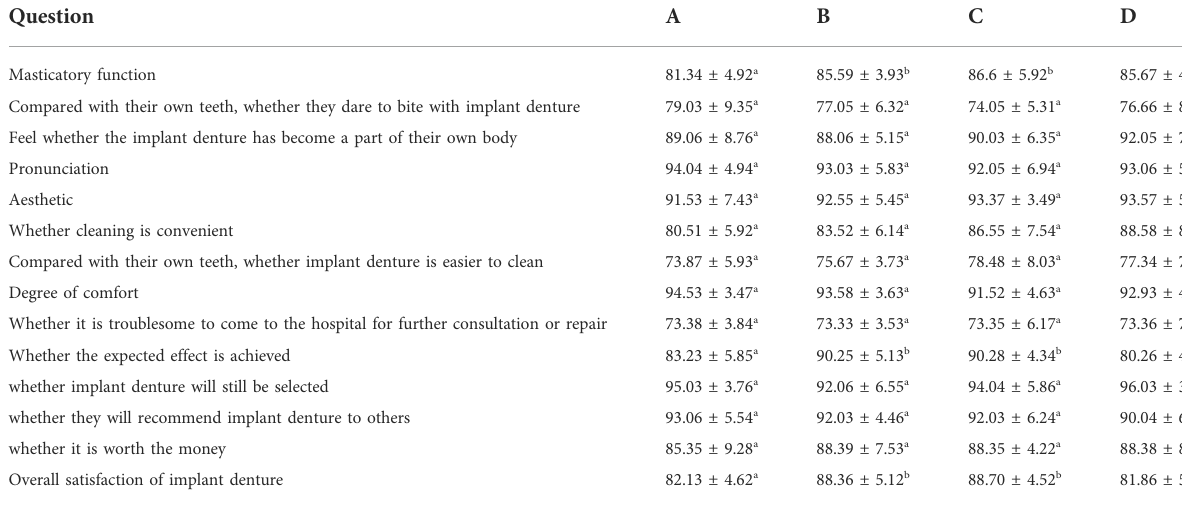
TABLE 4 Statistics of the VAS scores of four groups A – D after 3 years of weight bearing. Question